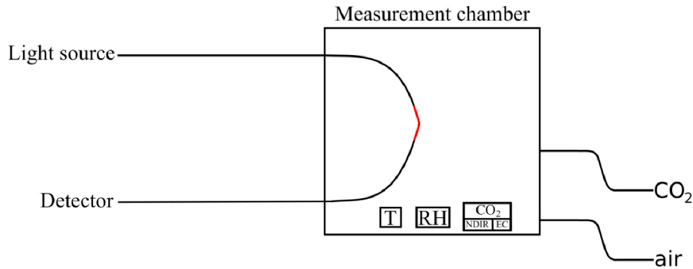
Figure 1. Measurement set up used for CO 2 sensing. The red fragment represents the optical fibre sensor.